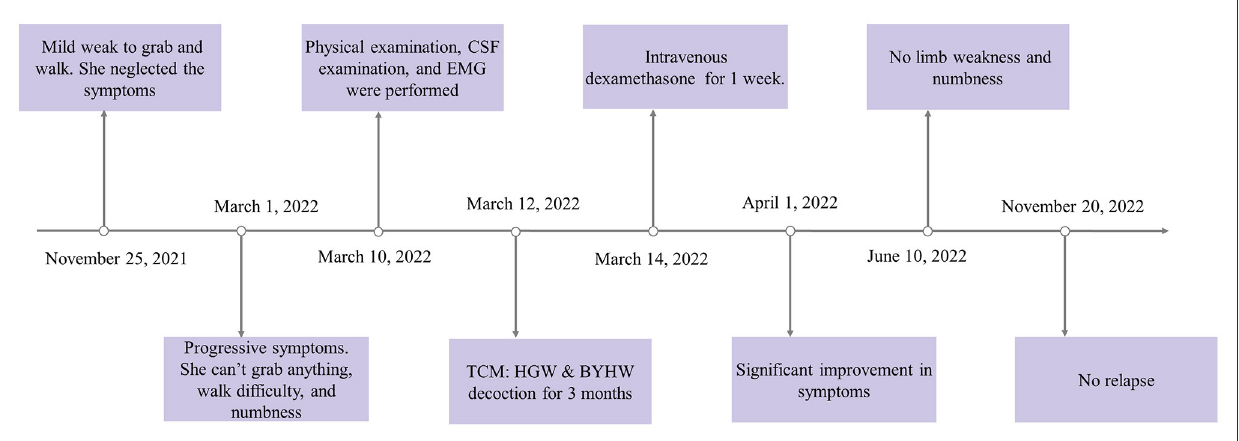
FIGURE1 Timeline of the case report. HGW and BYHW decoctions, Huangqi-Guizhi-Wuwu and Bu-Yang-Huan-Wu decoctions; CSF, cerebrospinal fluid; EMG, electromyography.